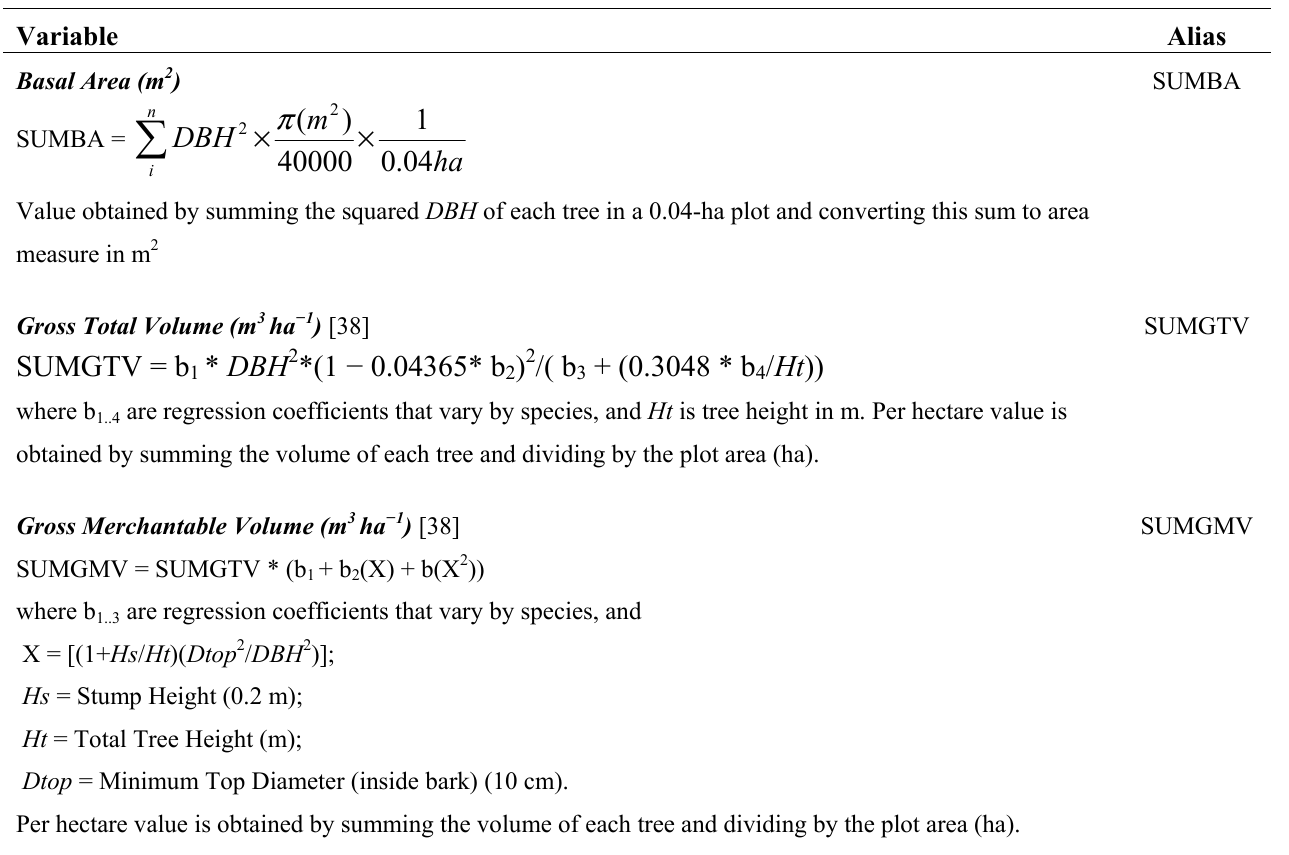
Table 1. The forest variables considered for this